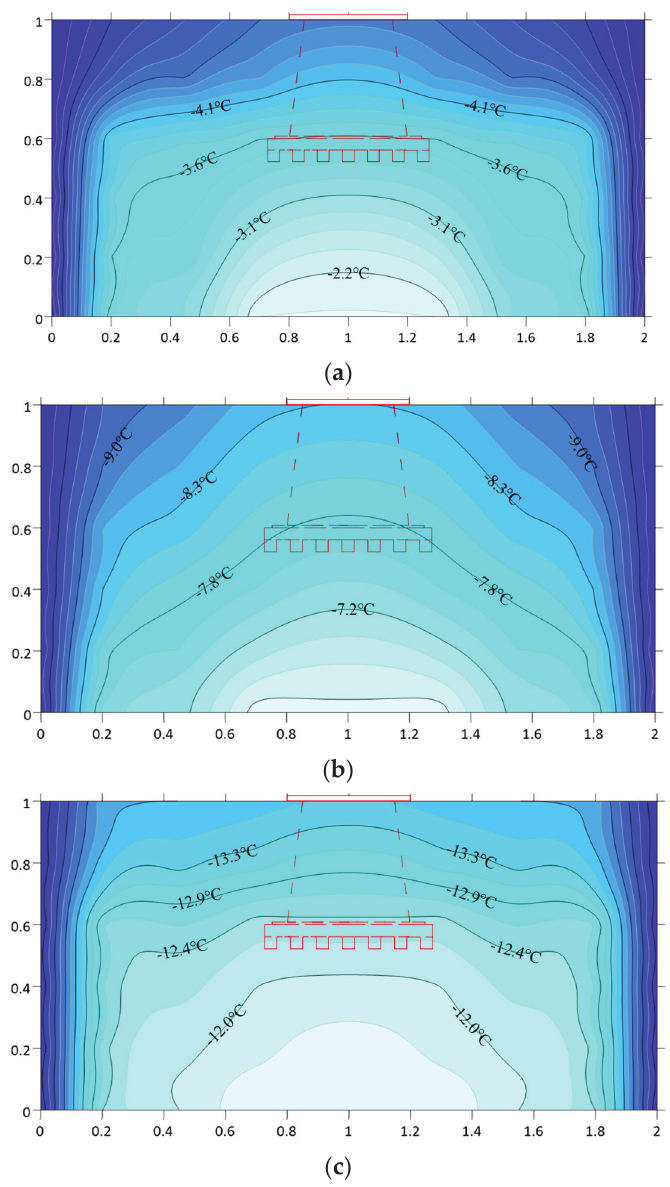
− 5 ◦ C, ( b ) − 10 ◦ C, and ( c ) − 15 ◦